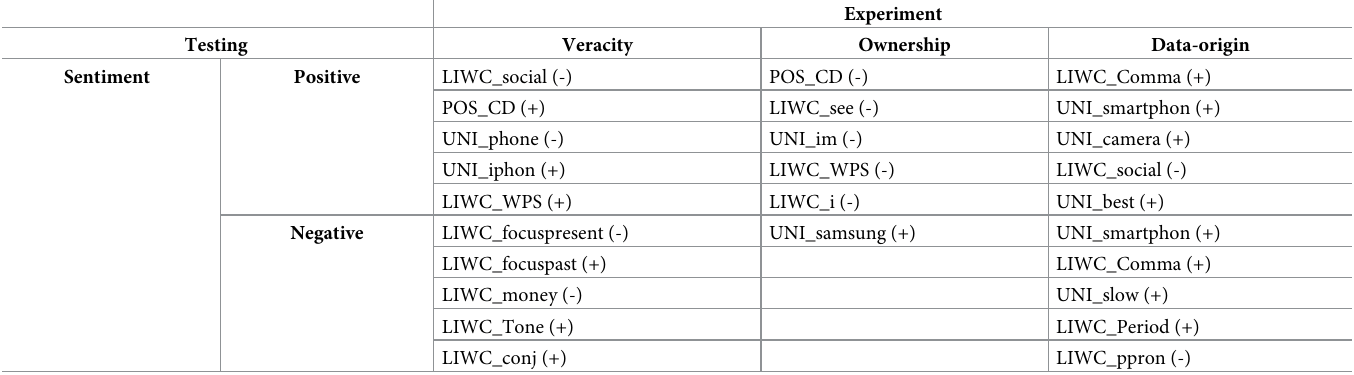
Table 3. Top 5 feature differences by BF 10 for all pure classifications; BF 10 > 11 for each feature; (+) = feature appears more often in truthful reviews, in reviews by smartphone non-owners, or in Prolific reviews; (-) = feature appears more often in deceptive reviews, in reviews by smartphone owners, or in Amazon reviews; see S6 Table for all feature